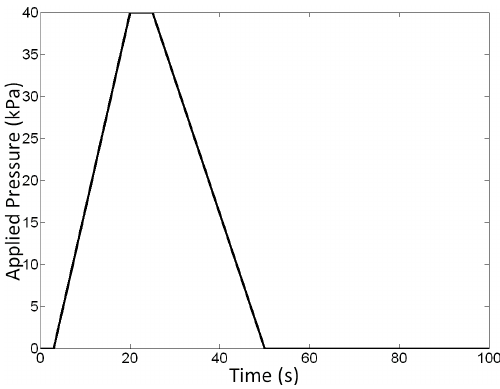
Fig. 11. Time evolution of the pressure over Wall 1 . P max corre- sponds to the maximum pressure reached (in this case